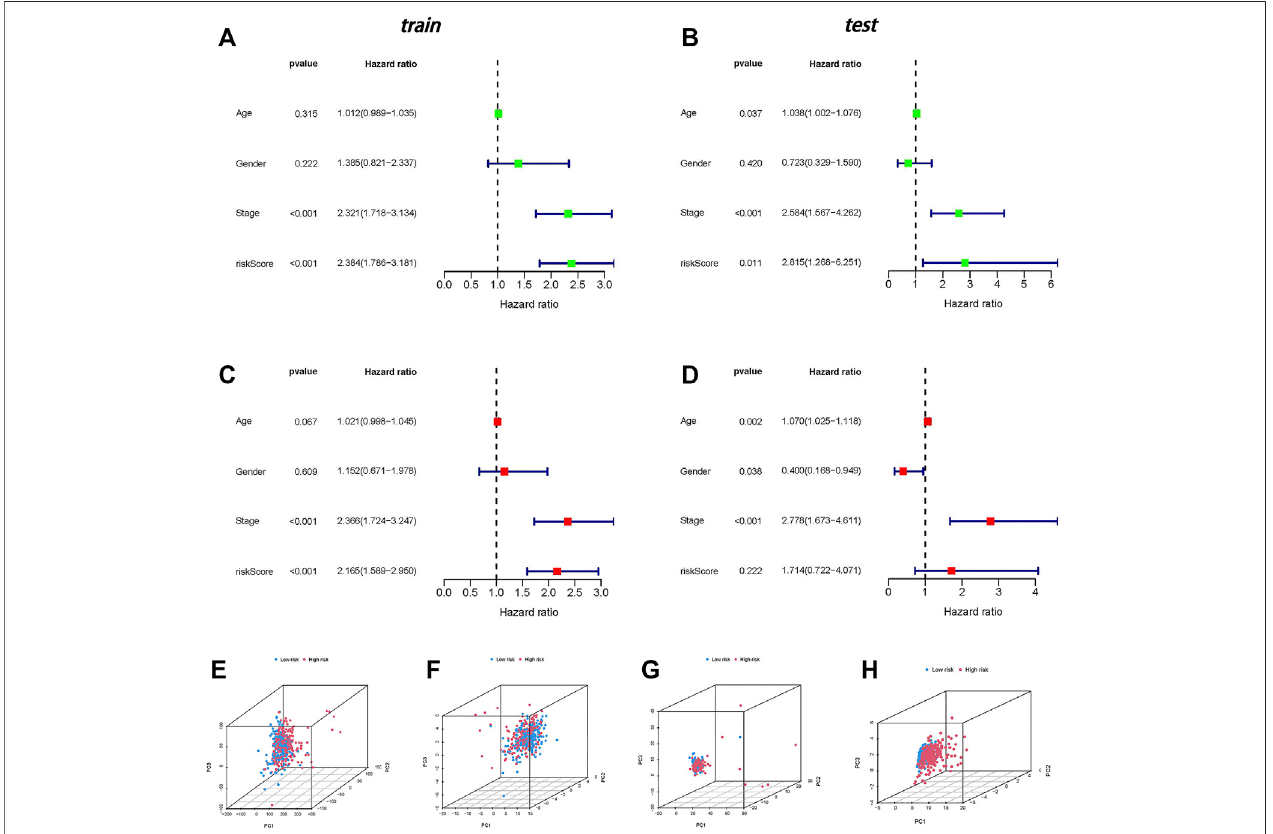
FIGURE4| IndependentprognosticanalysisandPCA. (A) Univariateindependentprognosticanalysisinthetraininggroup. (B) Univariateindependentprognostic analysisinthetesting group. (C) Multivariate independent prognostic analysisinthetraininggroup. (D) Multivariateindependent prognostic analysisinthetestinggroup. (E) PCA of all genes. (F) PCA of necroptosis genes. (G) PCA of necroptosis-related lncRNAs. (H) PCA of risk